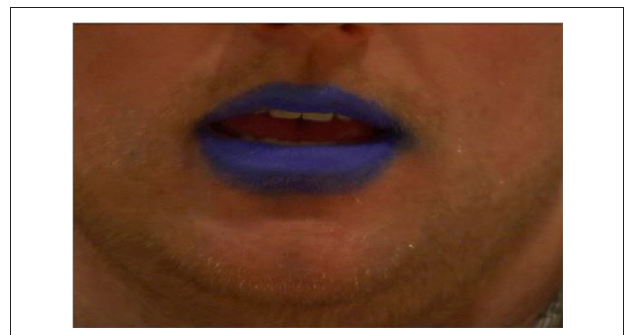
FIGURE 4 | Example of a visual stimulus presented to the participant.